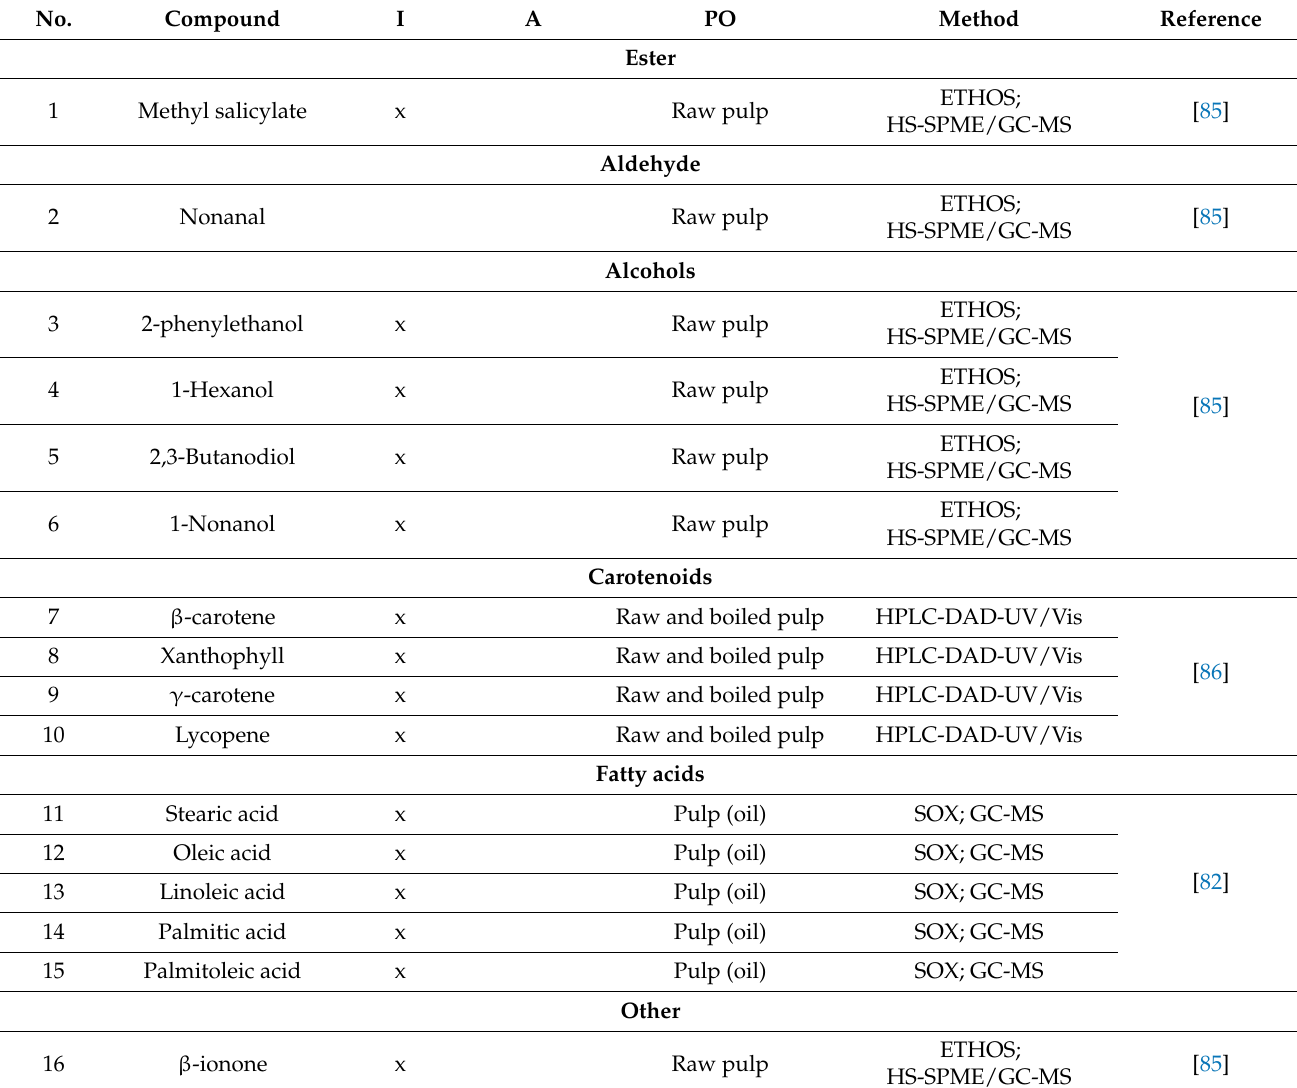
Table 8. Phytochemical composition of the fruit of Bactris gasipaes